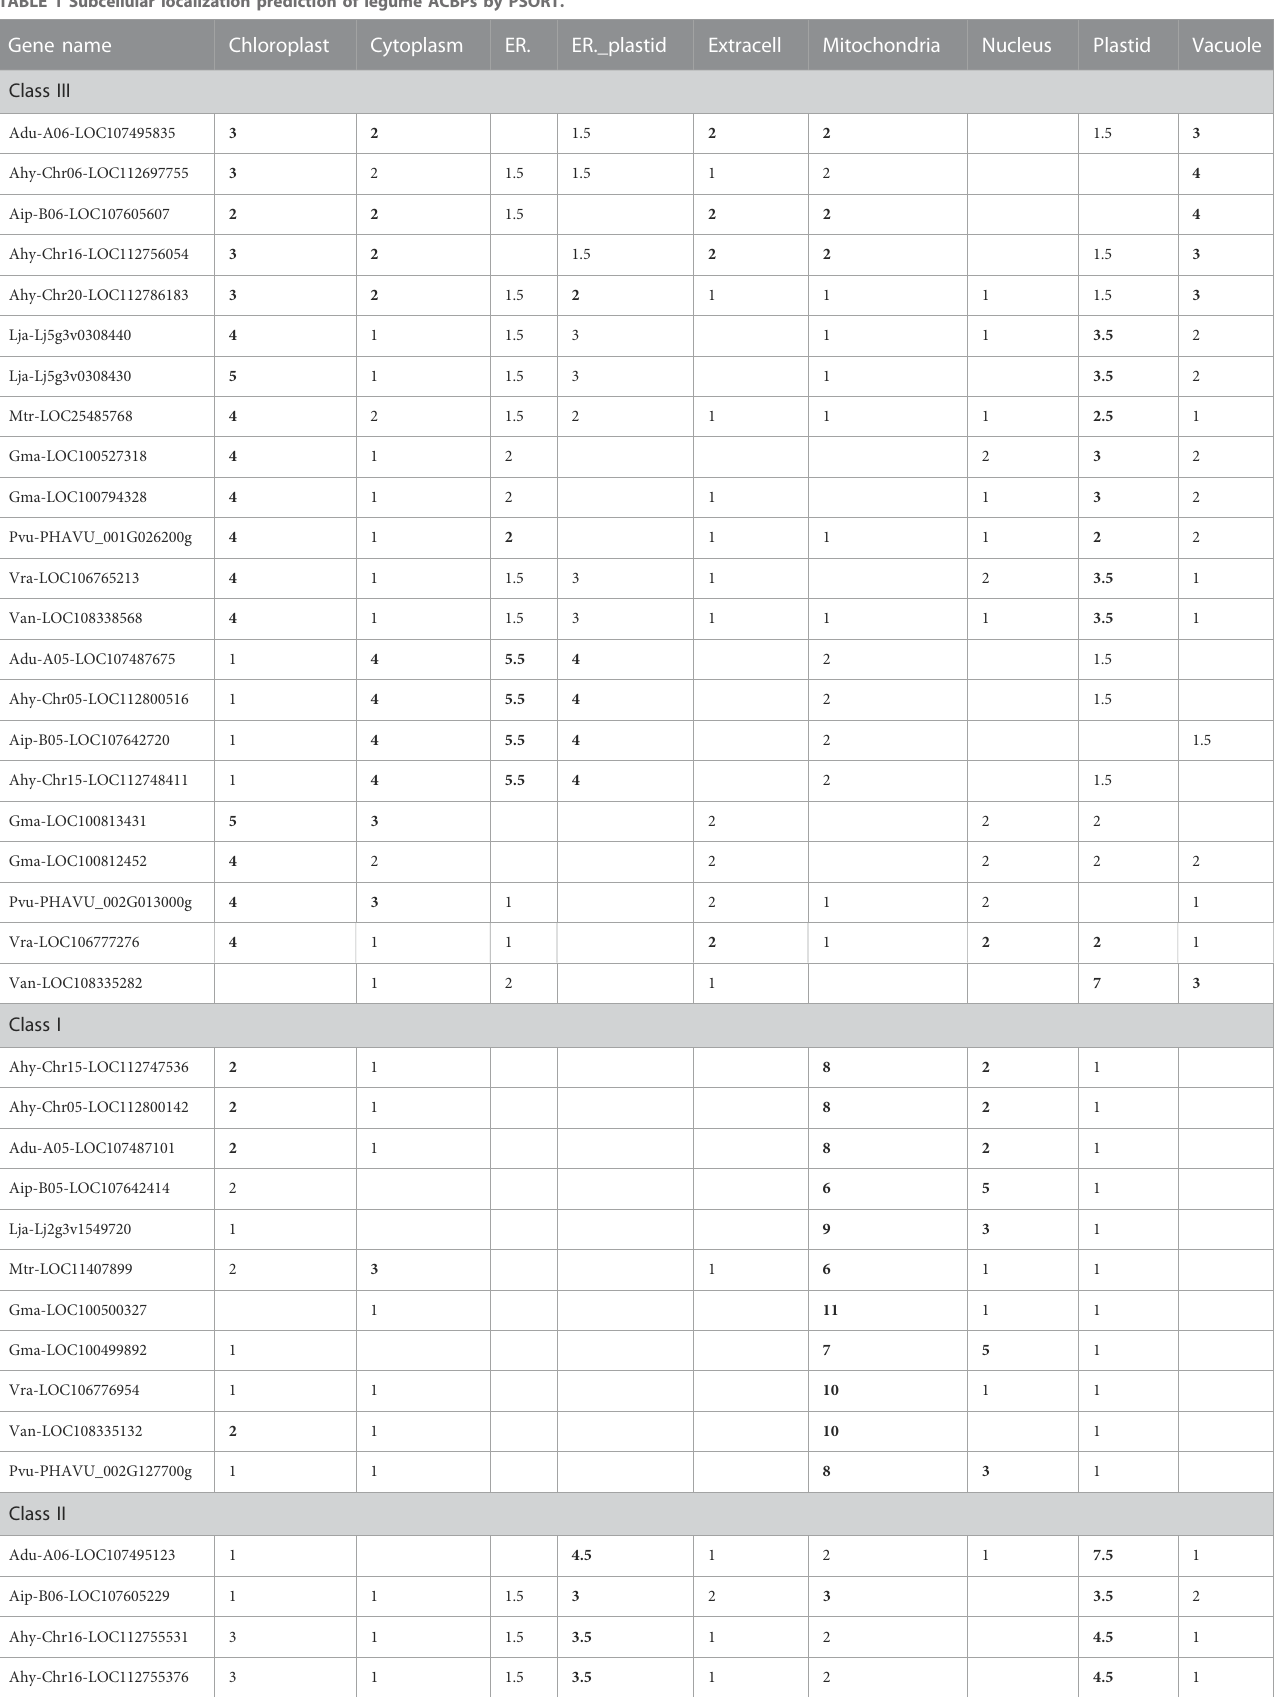
TABLE 1 Subcellular localization prediction of legume ACBPs by